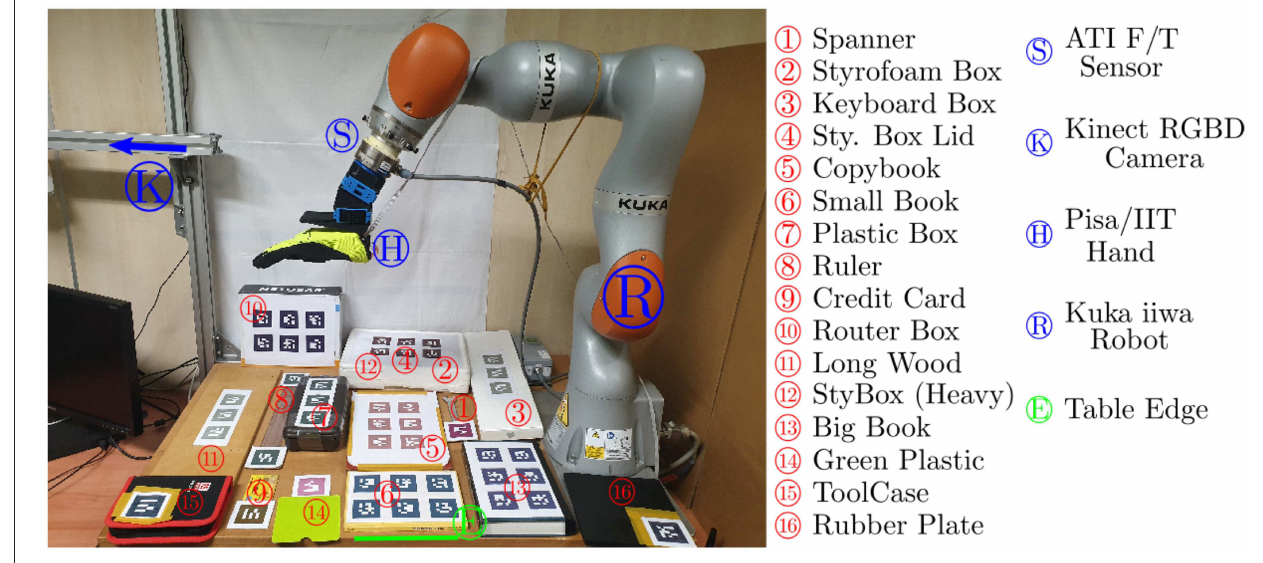
FIGURE 9 | Experimental setup and tested